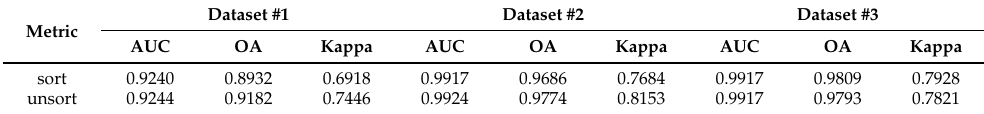
Table 6. Quantitative analysis of the SNLSW and NLSW on Datasets #1/2/3 with w 1 = 2, w 2 = 5. Metric